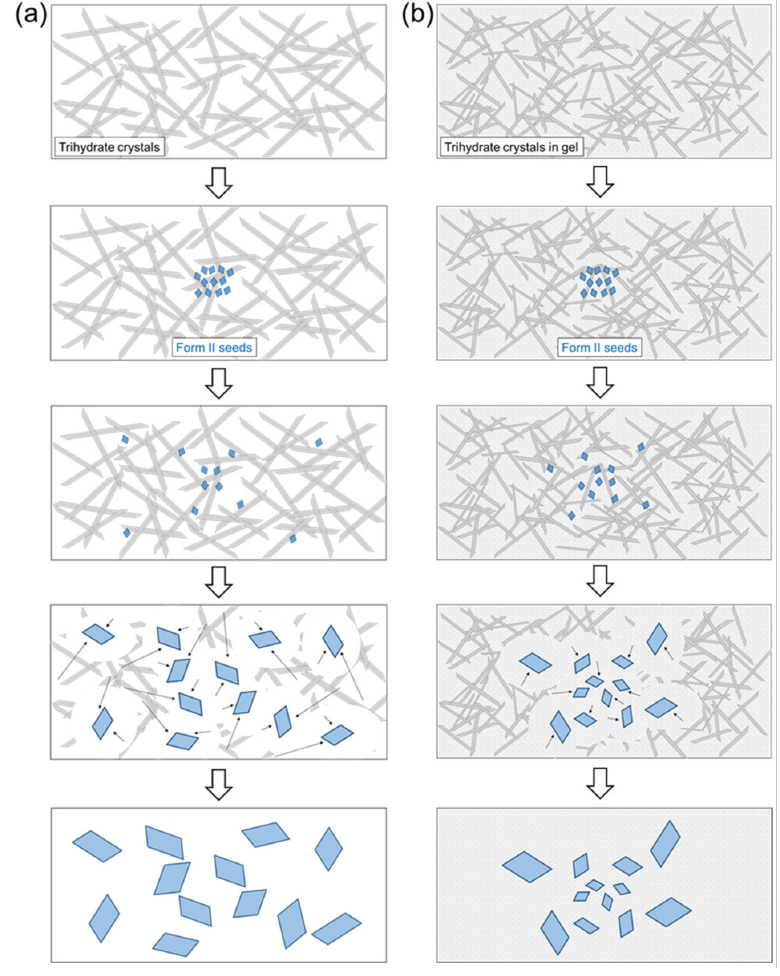
Figure 6. Schematic illustrations of the solution-mediated phase transition from trihydrate to form II by form II seeding. ( a ) The absence of agarose. ( b ) The presence of agarose. The dotted arrows represent the supply routes of solute molecules to form II